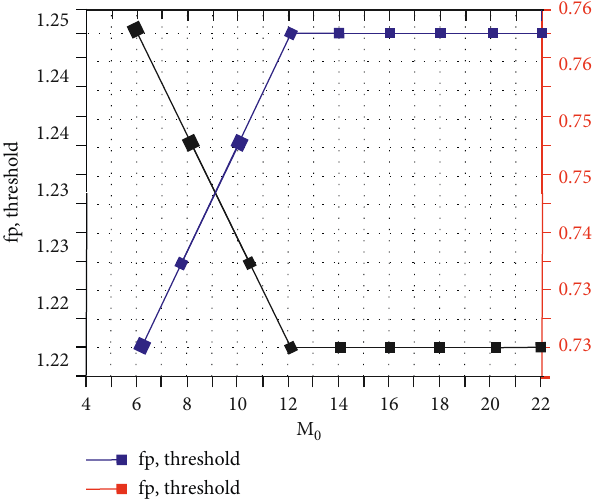
Figure 4: Coefficients for the one-dimensional steady-state shock problem. Distribution curve of stability threshold with f p as a function of Mach number.